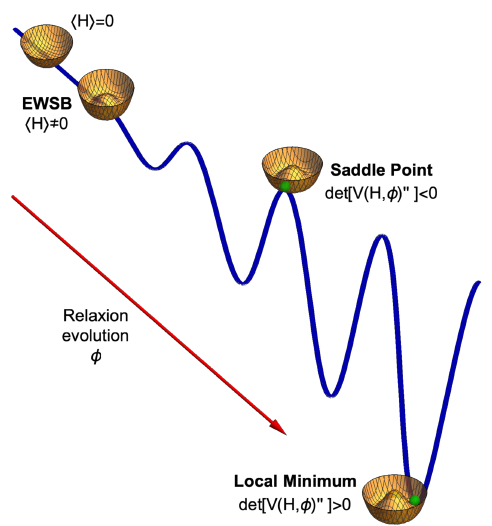
Figure 7. Sketch of the electroweak relaxation mechanism. At the beginning of the relaxion evolution the Higgs squared mass parameter is positive and h H i = 0 . As φ evolves it drives h H i 6 = 0 . Once the Higgs VEV is turned on, a back-reaction is generated, stopping the evolution. We also show the sign of the determinant of the matrix of second derivatives of the potential, important in deriving eq.